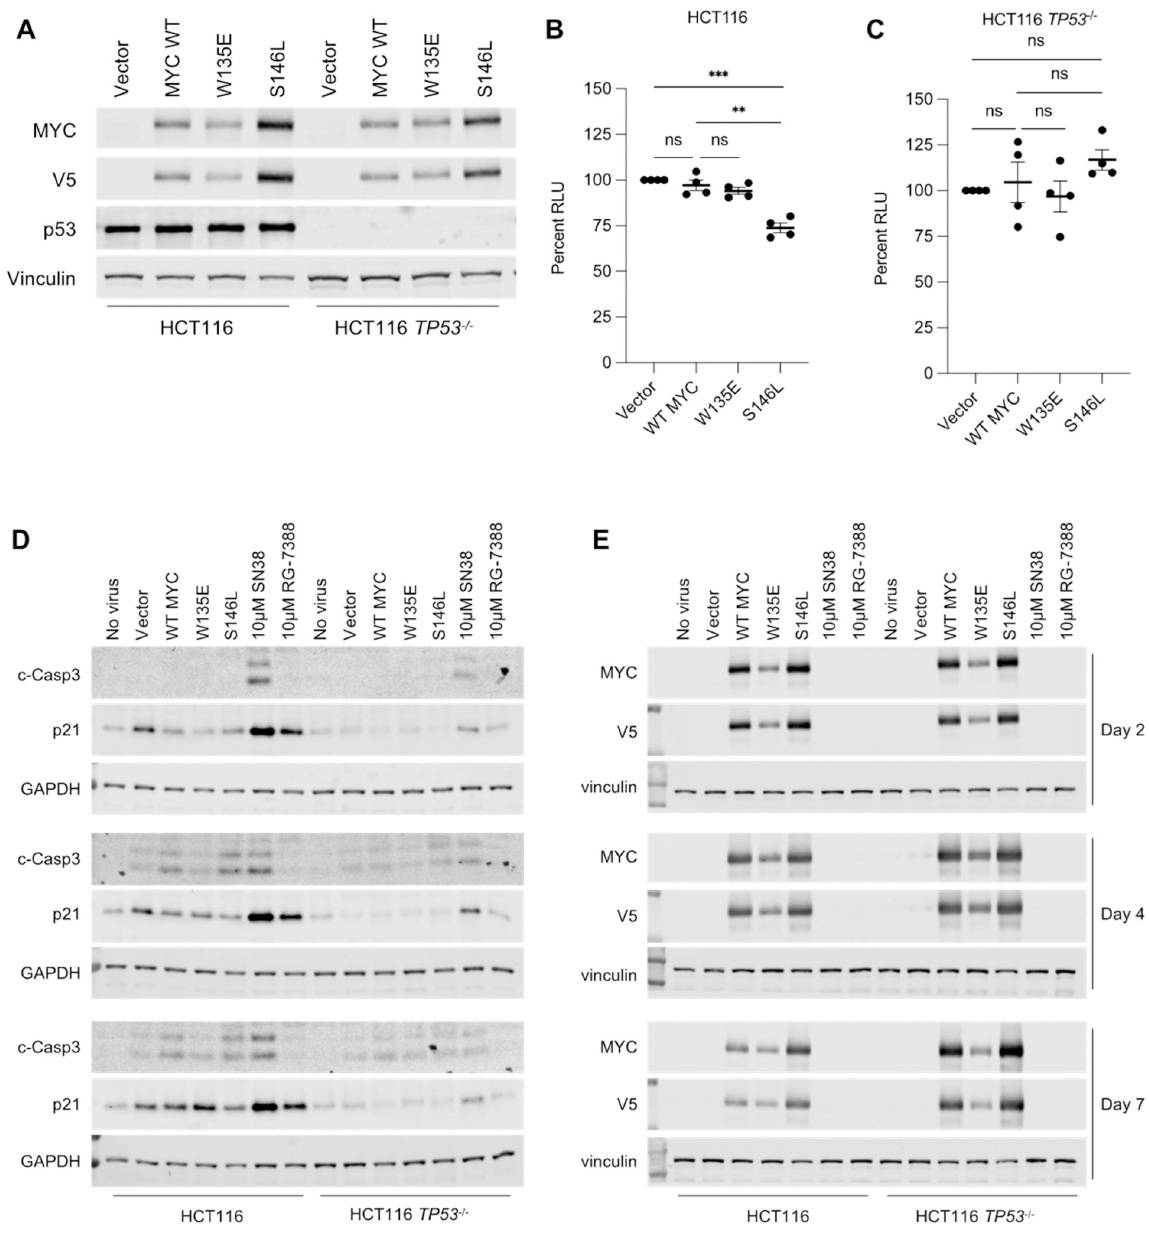
Fig 6. Growth inhibitory effect of S146L in HCT116 cells is p53 dependent. (A) Western blot confirming stable expression of V5-MYC WT, W135E, AND S146L in HCT116 and HCT 116 TP53 -/- cells. (B and C) growth in low attachment of the indicated cell lines stably expressing WT MYC, MYC W135E and MYC S146L relative to vector. Percent RLU = relative luminescence units (arbitrary). Statistics: Holm-Sˇida´k test, ns = not significant, �� p < 0.01, ��� p < 0.001. n = four independent experiments. (D and E) HCT116 and HCT 116 TP53 -/- cells were transduced with equivalent amounts of lentivirus expressing the indicated MYC substitutions under the control of an EF1alpha promoter. Samples were collected for analysis at the indicated timepoints and analyzed by western blotting for the indicated proteins. GAPDH and vinculin were used as loading controls. As a control for the induction of Caspase 3 cleavage (c-Casp3) and p21 expression between experimental timepoints, cells were treated for 24h with the topoisomerase-I inhibitor SN38 or the MDM2 inhibitor RG-7388 at the specified concentrations. MYC, W135E, or S146L (Fig 6D). Western blotting for MYC expression in these cells demon- strated that relative levels of WT MYC, W135E, and S146L remained consistent throughout the time course, suggesting that no differential selection based on MYC expression alone